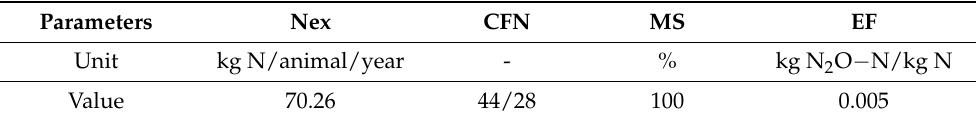
Table 2. Parameters used for calculation of N 2 O emissions from manure management for cattle (based on